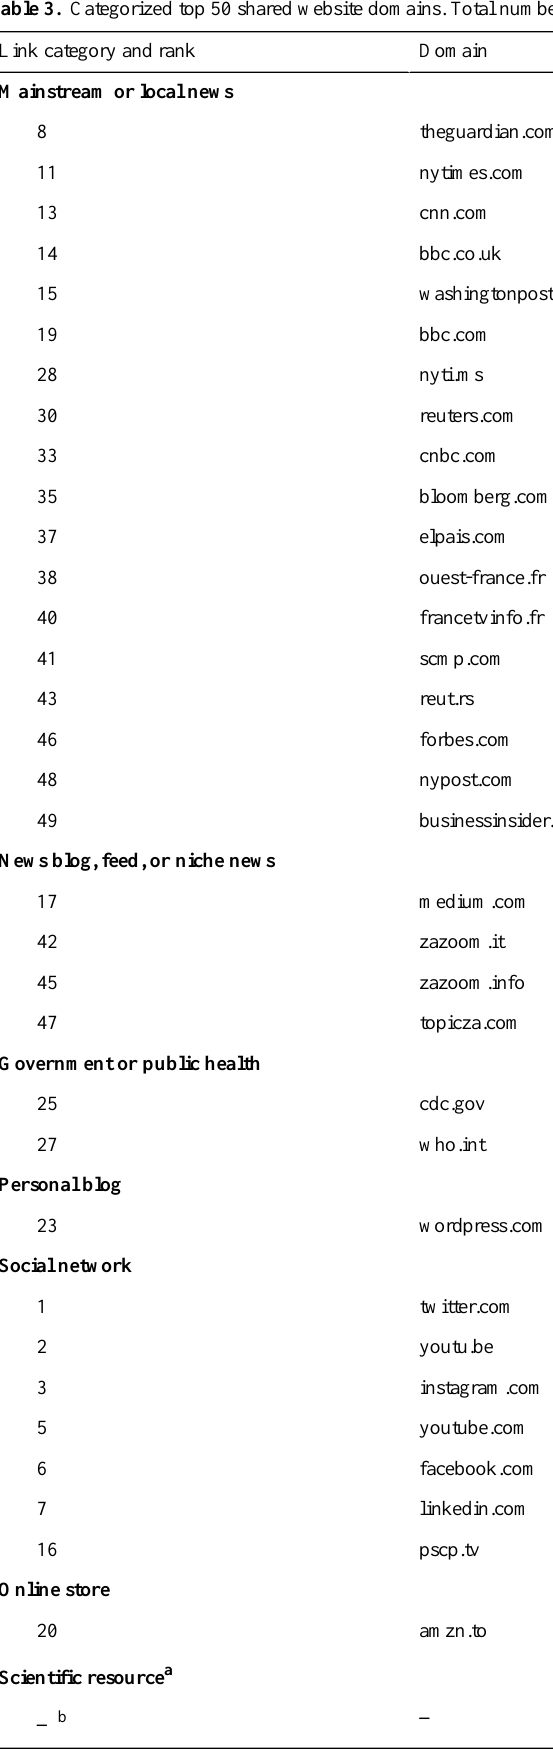
Occurrences, n (%)DomainLink category and